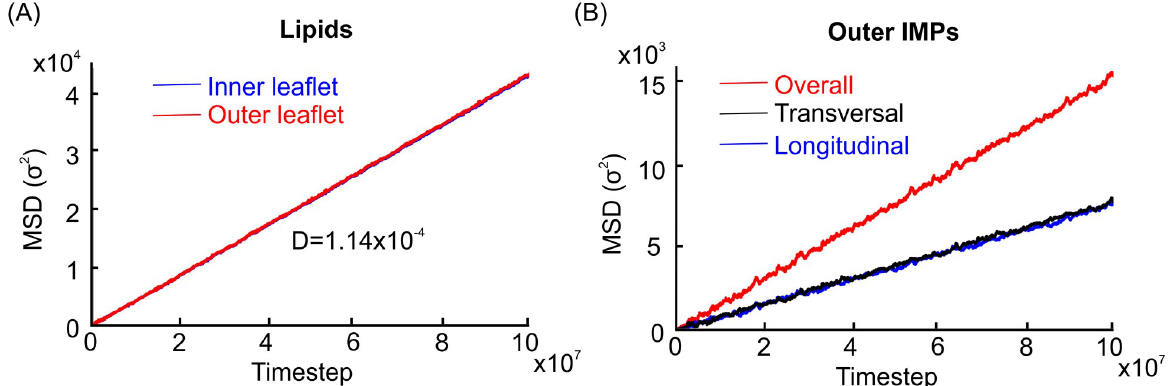
Fig 3. MSDs of lipids and IMPs of the outer leaflet. (A). 2D MSDs of lipids of inner and outer leaflets. (B). MSDs of outer leaflet IMPs in longitudinal and transversal directions. The overall MSD is the summation of longitudinal and transversal MSDs and represents surface diffusion.